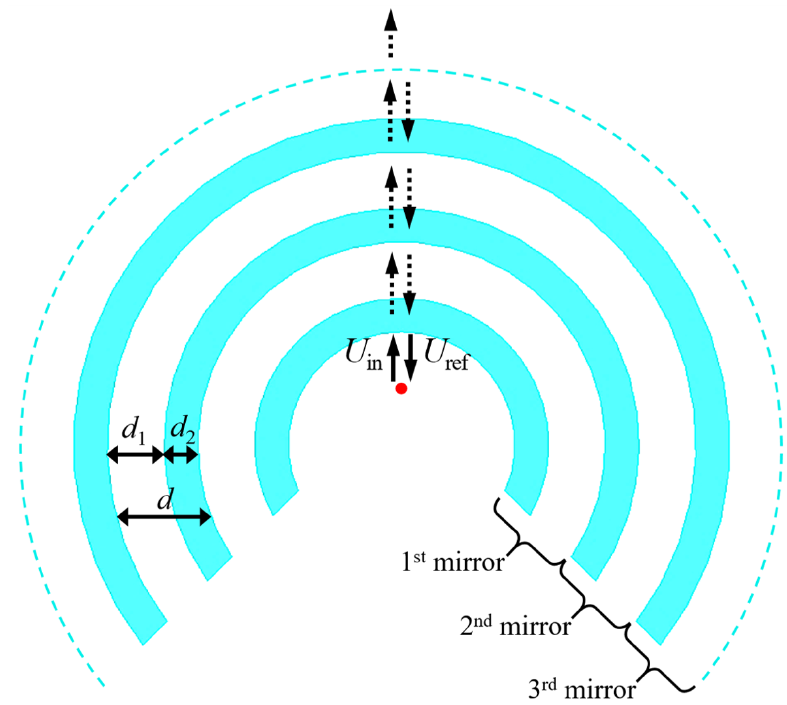
Figure 2. Illustration of the proposed quarter wavelength stack mirror. The red dot represents a half-wave dipole antenna as seen from above. The light-blue curves represent the quasi-cylindrical dielectric layers, and the white background represents